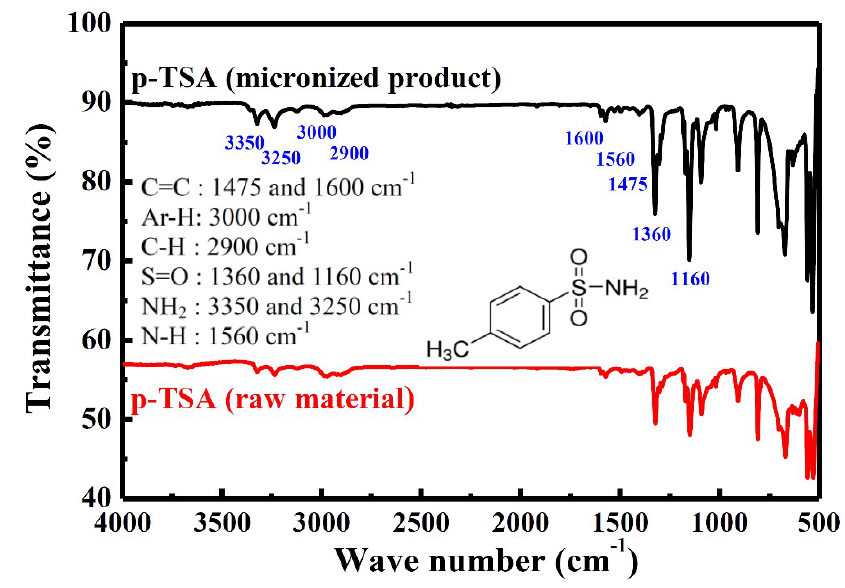
Figure 6. FTIR spectra of raw and micronized p-TSA.